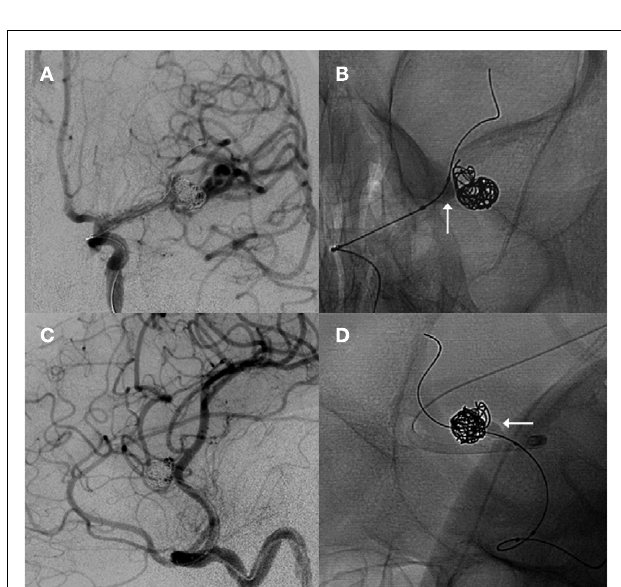
FIGURE 4 |A large wide-neck paraophthalmic artery aneurysm with the ophthalmic artery arising from the aneurysm neck (A) was treated withAscent balloon remodeling [(B), black arrow]. Complete aneurysm occlusion was achieved with preservation of the ophthalmic artery [ (C) , white